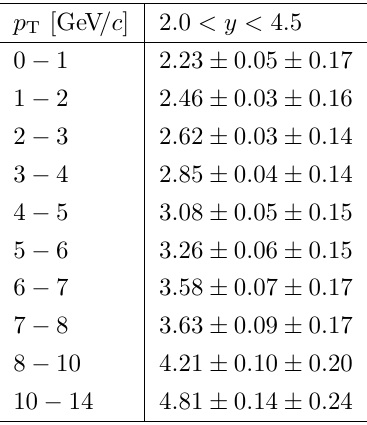
Table 16 . Cross-section ratios between 13 TeV and 5 TeV measurements for nonprompt J/ψ mesons as a function of p T with 2 . 0 < y < 4 . 5 . The first uncertainty is statistical and the second is systematic.